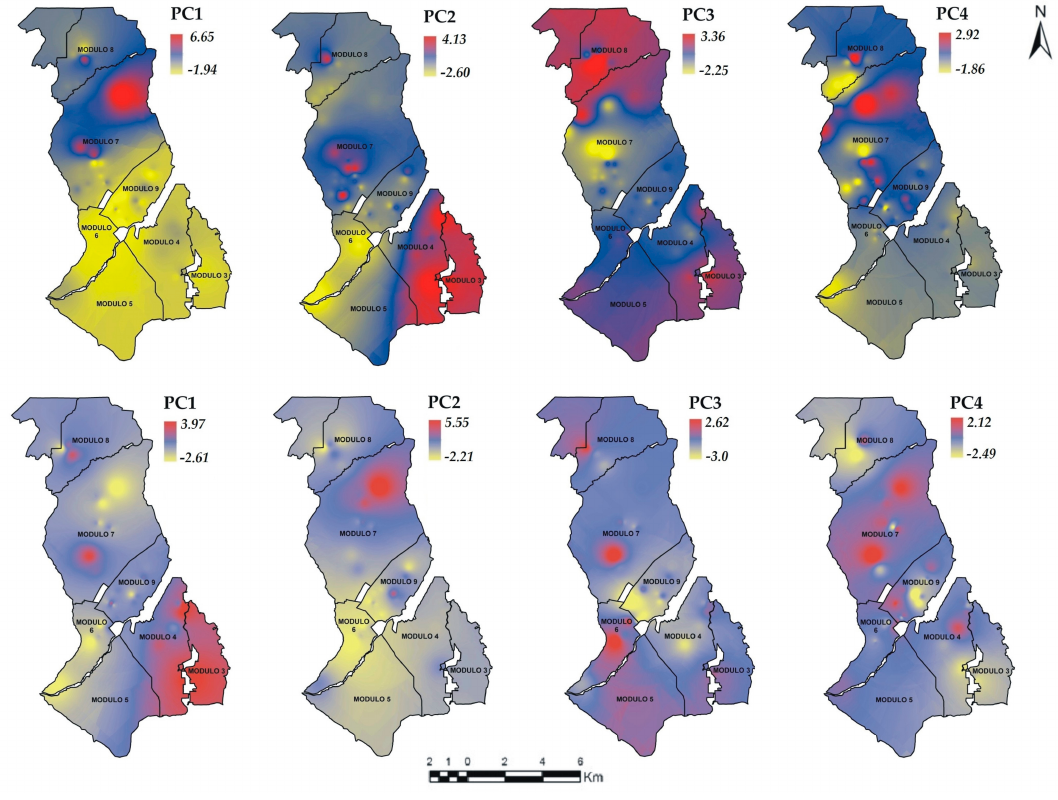
Figure 8. Spatial distribution of the PC scores of S1 ( top ) and S2 ( bottom ). PC = Principal component, studied modules (—).